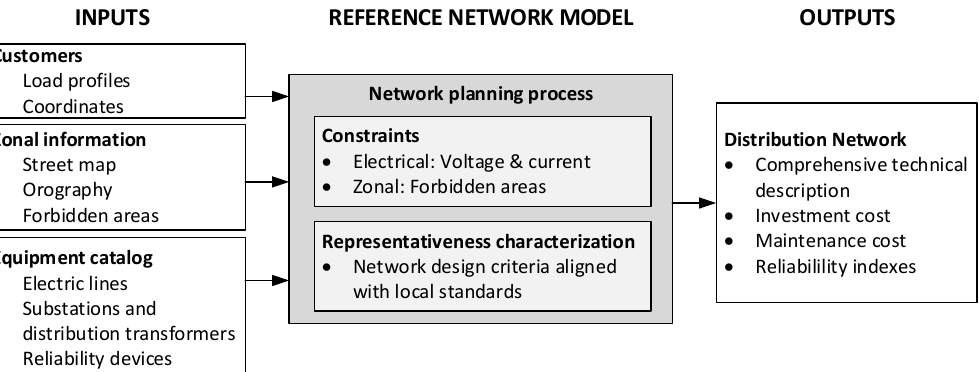
Figure 3. Components of a reference network model proposed for developing advanced, large-scale test systems.